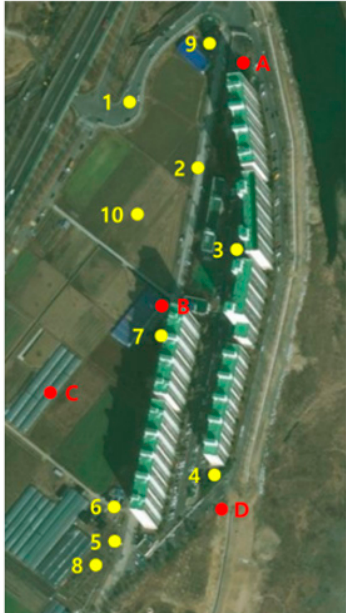
Water 2021 , 13 , x FOR PEER REVIEW